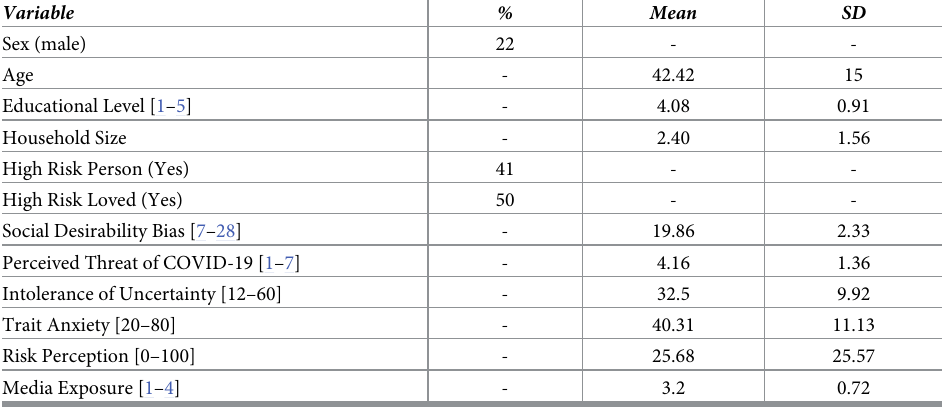
Table 1. Descriptive